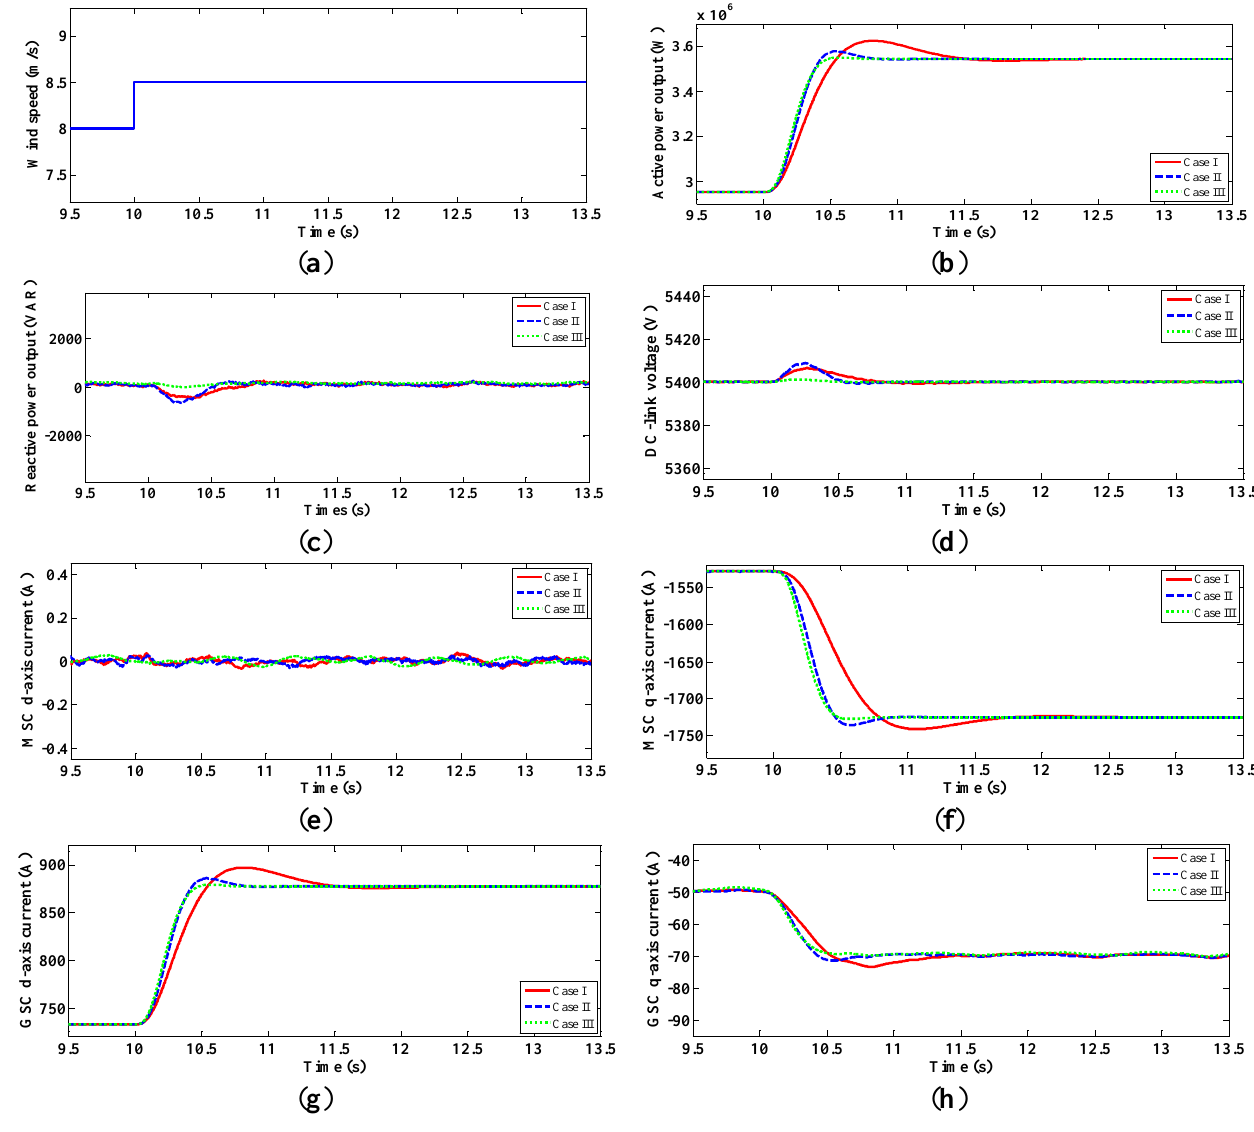
Figure 9. Simulation test results for three cases. ( a ) Wind speed; ( b ) Active power output; ( c ) Reactive power output; ( d ) DC-link voltage; ( e ) MSC d -axis current; ( f ) MSC q -axis current; ( g ) GSC d -axis current; ( h ) GSC q -axis